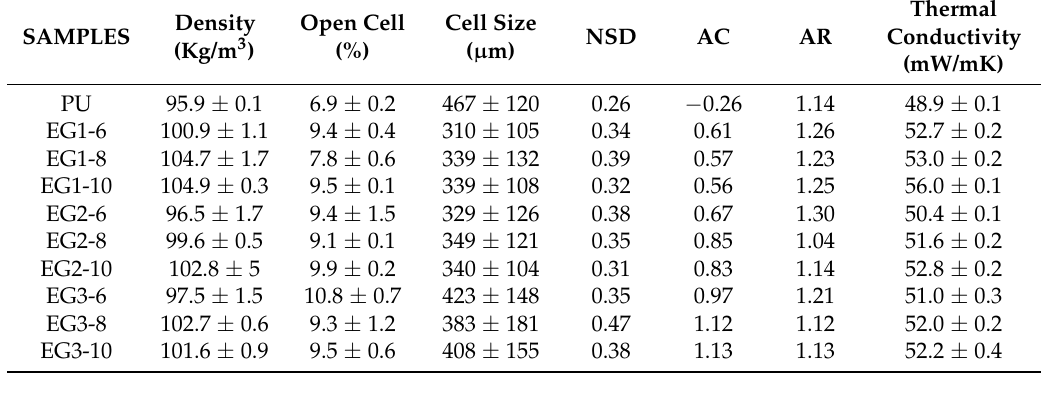
Table 2. Main characteristics of the cellular structure of EG/PU foams, density, and thermal conductivity values.